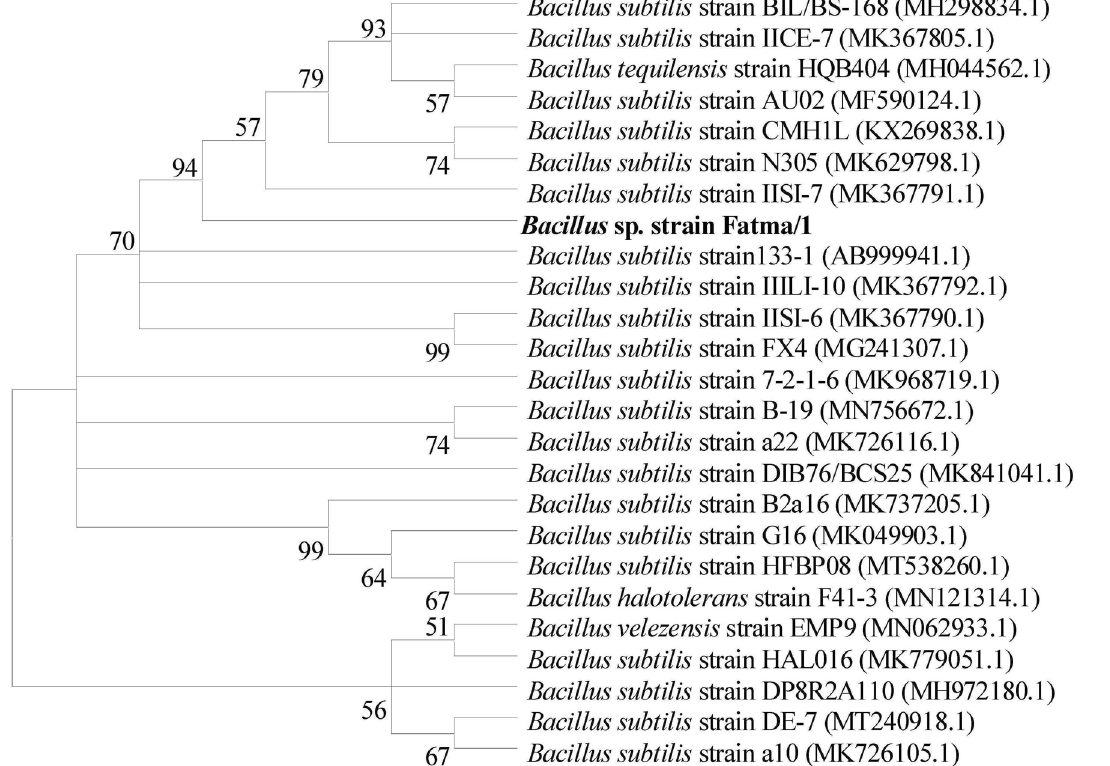
Figure 3. Phylogenetic tree showing the relationship between bacterial isolate Fatma/1 and other Bacillus